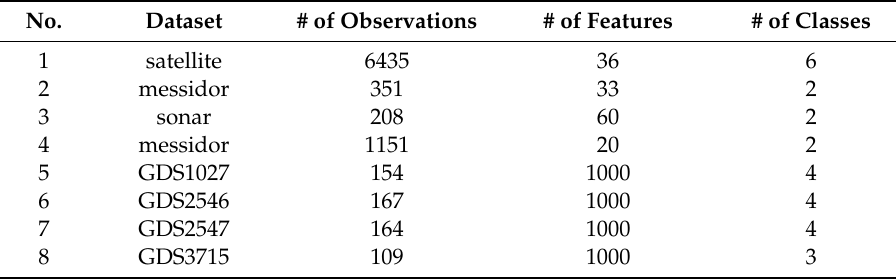
Table 1. List of benchmark datasets.